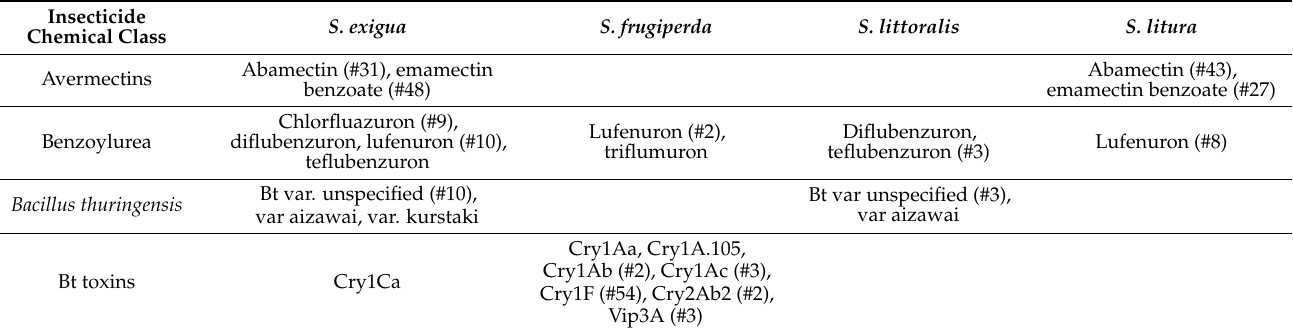
Table 1. Assessment of insecticide resistance worldwide for the four species of Spodoptera , data extracted from the Arthropod Pesticide Resistance Database (http://www.pesticideresistance.org, accessed on 18 May 2021). Insecticide Chemical